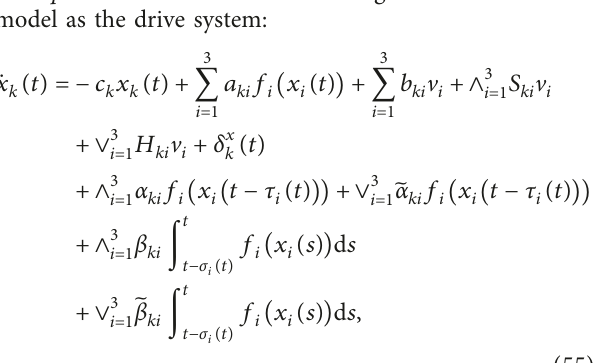
( t ) and y ( t ) for drive-response system under controller (53); (b) trajectories of x 1 1